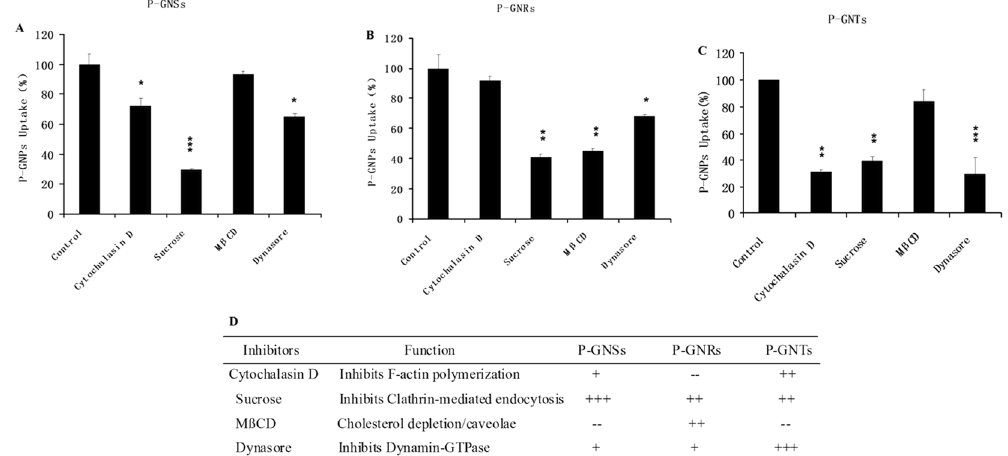
Figure 6. Uptake % of P-GNSs ( A ), P-GNRs ( B ) and P-GNTs ( C ) (compared to the positive controls) in the present of different endocytic inhibitors in the RAW264.7 cells. Error bars represent standard deviation. * p < 0.05, ** p < 0.01, *** p < 0.001 compared to the control. ( D )Summary of cellular uptake inhibition of P-GNPs in the present of endocytic inhibitors. + p < 0.05; ++ p < 0.01; +++ p < 0.001; – no significant